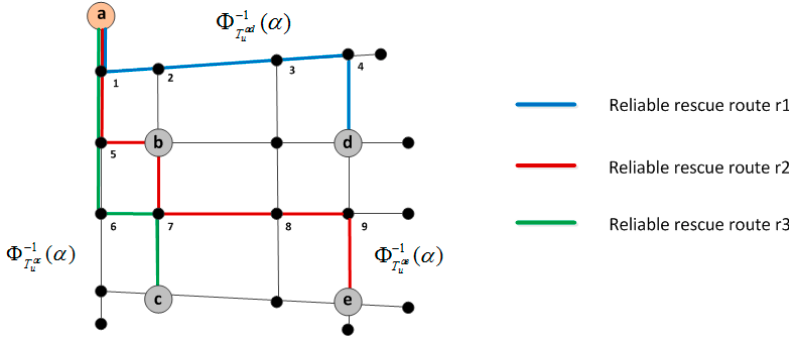
Figure 2. Example of α -reliable rescue routes from warehouse to affected areas.